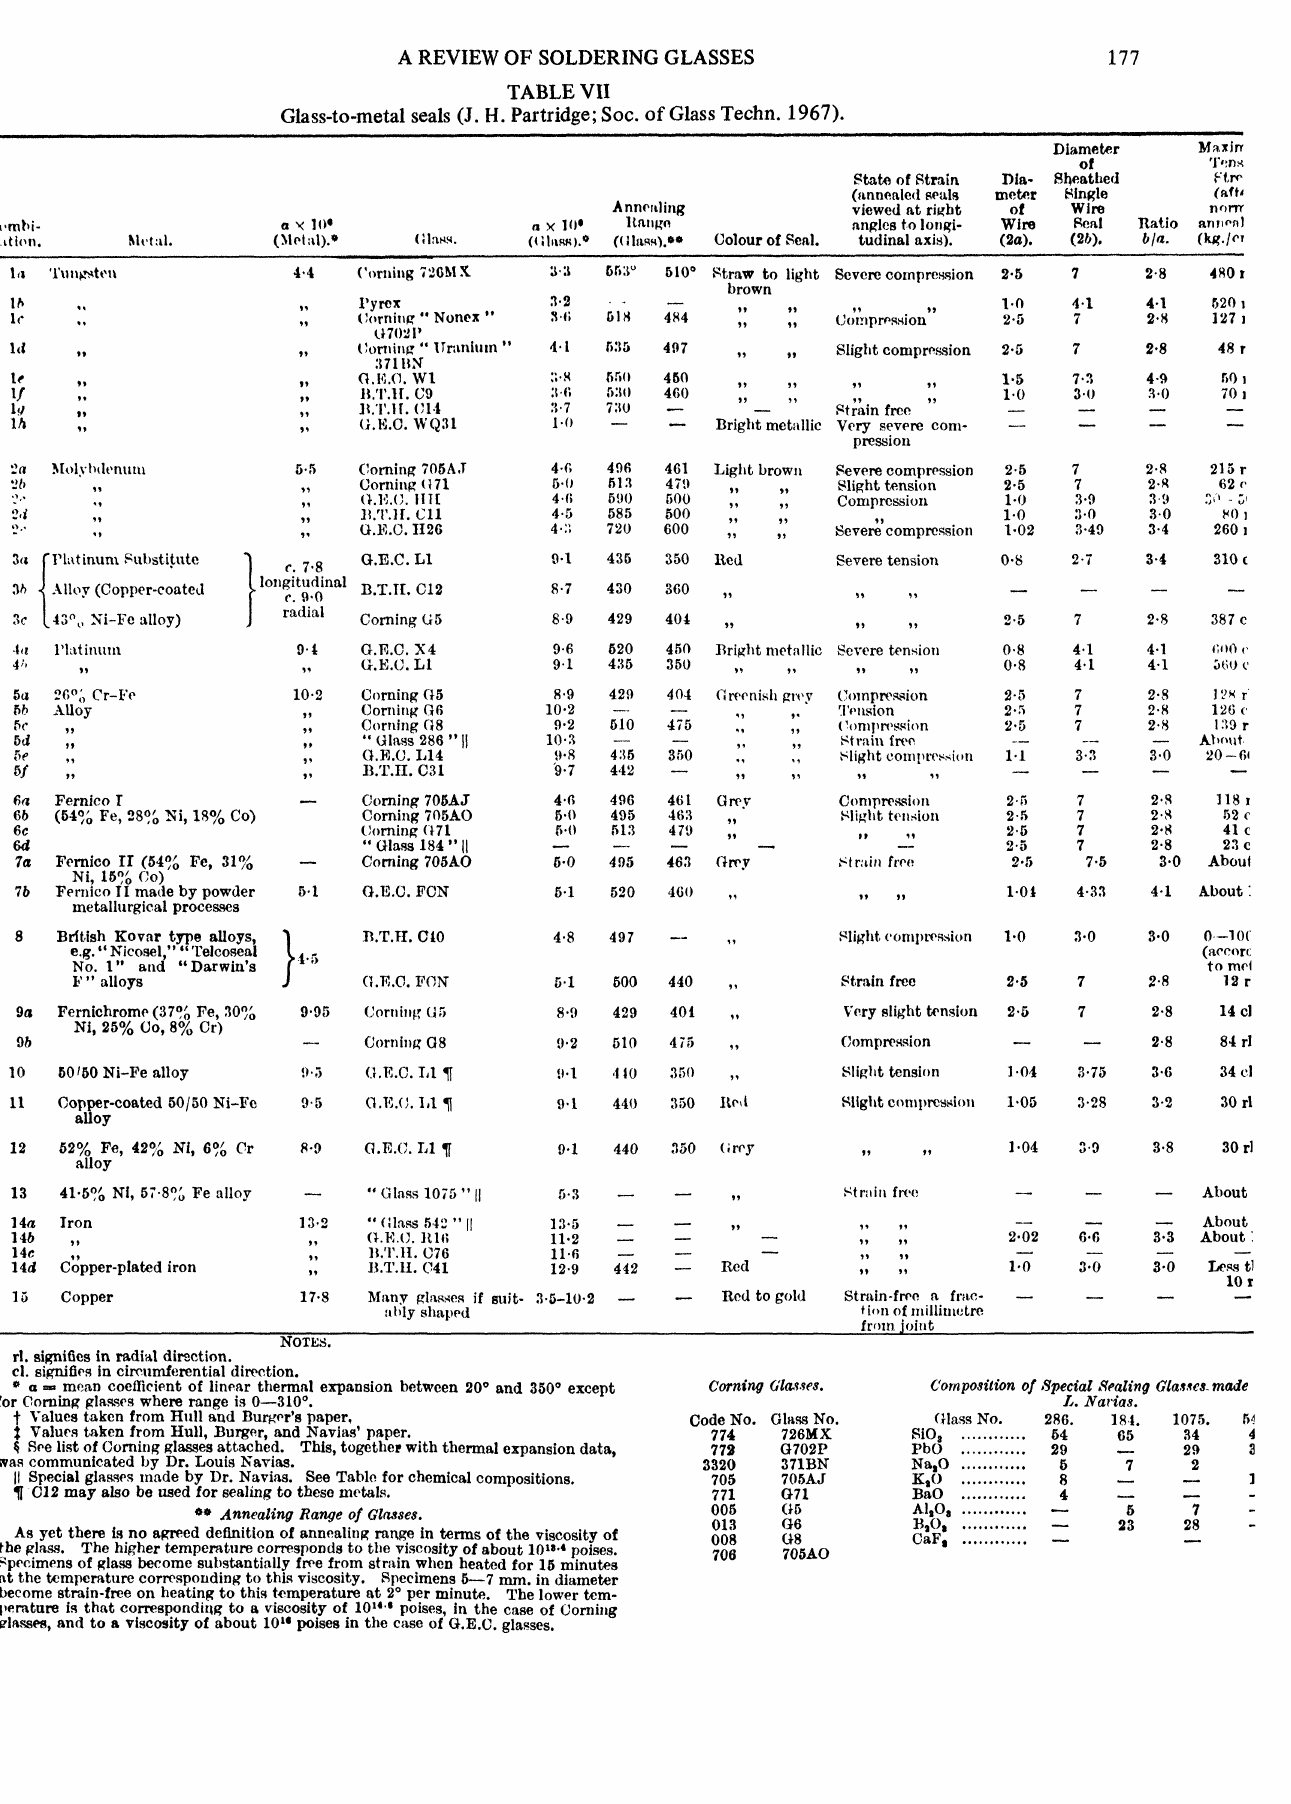
TABLE VII Glass-to-metal seals (J. H. Partridge; Soc. of Glass Techn.